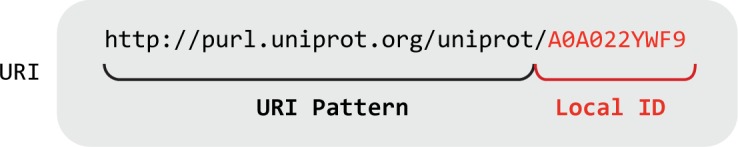
Anatomy of a web-based identifier.An example of an exemplary unique resource identifier (URI) is below; it is comprised of American Standard Code for Information Interchange (ASCII) characters and follows a pattern that starts with a fixed set of characters (URI pattern). That URI pattern is followed by a local identifier (local ID)—an identifier which, by itself, is only guaranteed to be locally unique within the database or source. A local ID is sometimes referred to as an “accession.” Note this figure illustrates the simplest representation; nuances regarding versioning are covered in Lesson 6 and Fig 5.